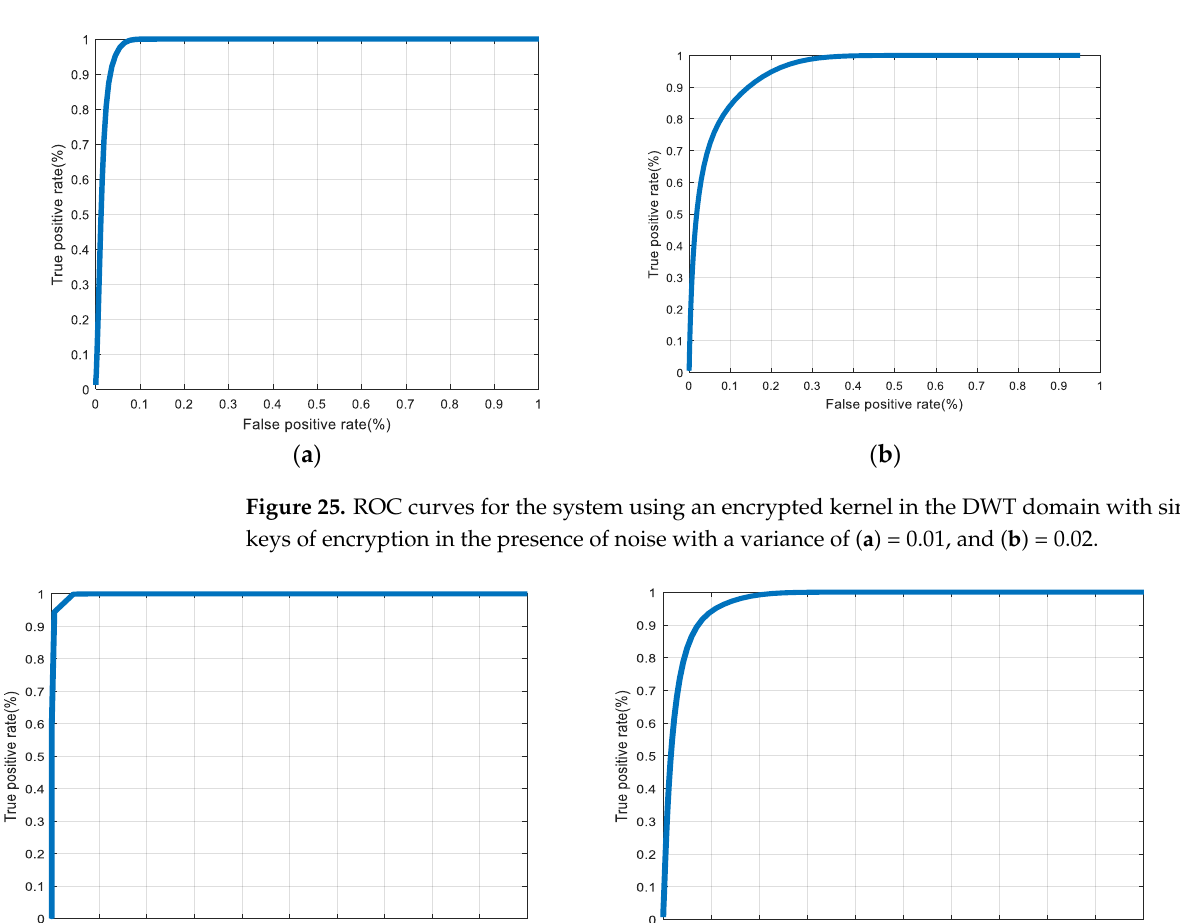
Table 6. Metrics for evaluating different domains of encryption in the cancelable biometric system in